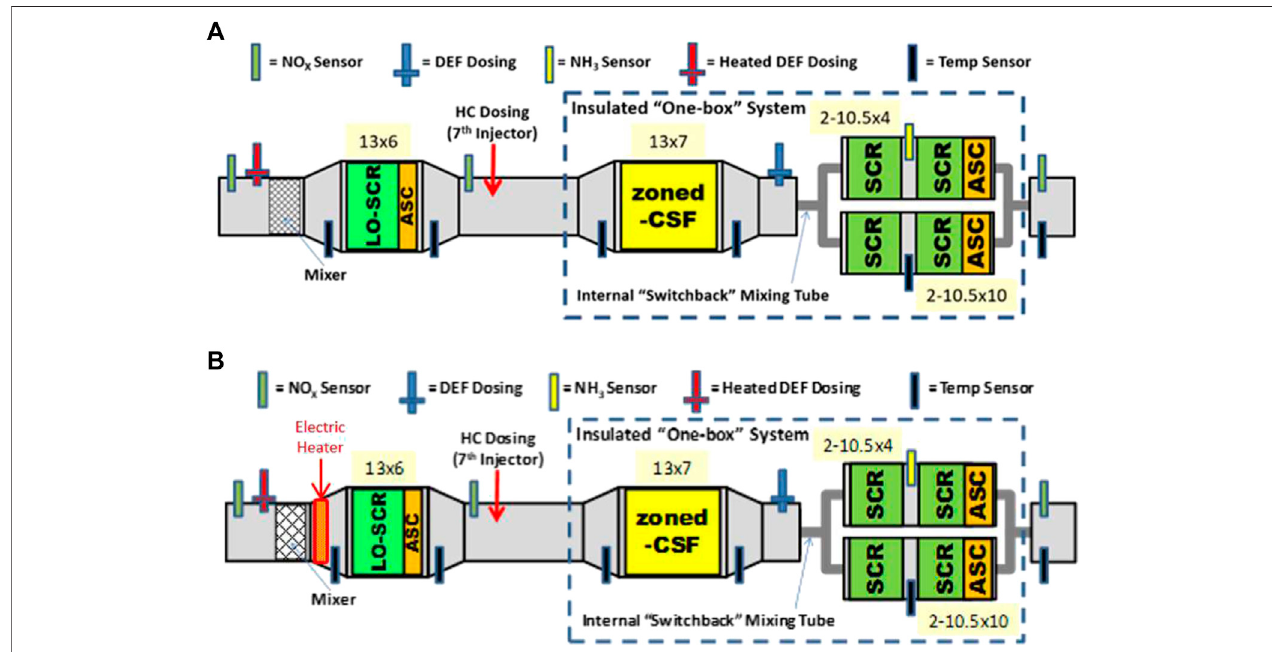
FIGURE 1 | (A) LO-SCR + Primary AT system used in combination with CDA for meeting upcoming emission regulations (Neely et al., 2020a; Sharp, 2020; Matheaus et al., 2021). (B) Electric heater (EH) placed upstream of the LO-SCR + Primary AT system used in combination with CDA for meeting upcoming emissions regulations (Matheaus et al., 2021).